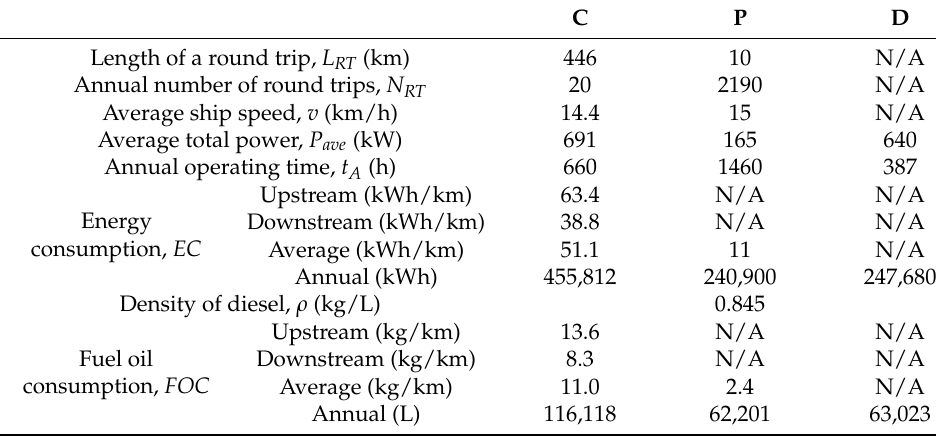
Table 4. Diesel engine-powered ship input data for LCA.